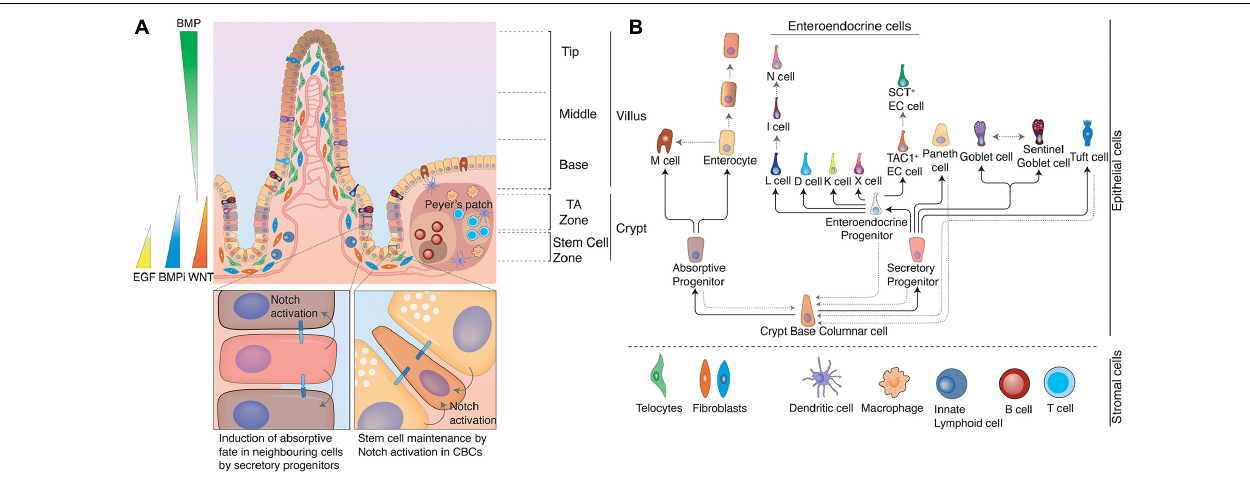
FIGURE 1 | Structure of the intestine. (A) The intestine is organized in crypt-villus units. At the bottom of the crypt, in the stem cell zone crypt-base columnar cells (CBCs) act as stem cells of the tissue and are intercalated between Paneth cells. Paneth cells are the primary niche of CBCs and provide them with Notch ligands, EGF, and WNTs to support their continuous proliferation. At the same time Paneth cells also produce anti-microbial products to protect CBCs. In the Transit Amplifying zone (TA zone) the highly proliferative absorptive and slow dividing secretory progenitors differentiate to their respective lineage. The ratio between absorptive and secretory progenitors is controlled via lateral inhibition. Epithelial cells moving from the crypt bottom toward the villus encounter several opposing signaling gradients, among them WNT and BMP. WNT signals, which are necessary for the stemness of CBCs, are higher at the crypt bottom and gradually decrease toward the villus, while increasing BMP levels induce differentiation and gradual fate changes as cells rise up toward the villus tips. These signaling gradients are shaped by mesenchymal populations, such as fibroblasts or telocytes. Distinct populations with differing secretory profiles constitute the mesenchymal stem cell niche adjacent to crypts or induce continuous fate changes along the villus. Gray solid arrows indicate cells with Notch activity. (B) Cell fate determination in the intestinal epithelium. Once CBCs leave the stem cell zone, they start to differentiate either toward the absorptive or the secretory fate depending on Notch signals. Secretory progenitor cells can give rise to Paneth cells, goblet cells, Tuft cells and enteroendocrine cells, while absorptive progenitors can give rise to microfold cells and enterocytes. However, fate changes are not unidirectional and can be reverted upon appropriate environmental stimuli, such as tissue damage. Likewise, certain intestinal epithelial populations (e.g., enterocytes, EE cells, and goblet cells) dynamically acquire and lose different functions and thus cell identities in the course of their lives due to the instructive capacity of changing environments that they traverse as they move along crypt and villus. Black solid arrows indicate cell fate decisions during the differentiation process and gray dotted arrows indicate documented plasticity events by distinct cell